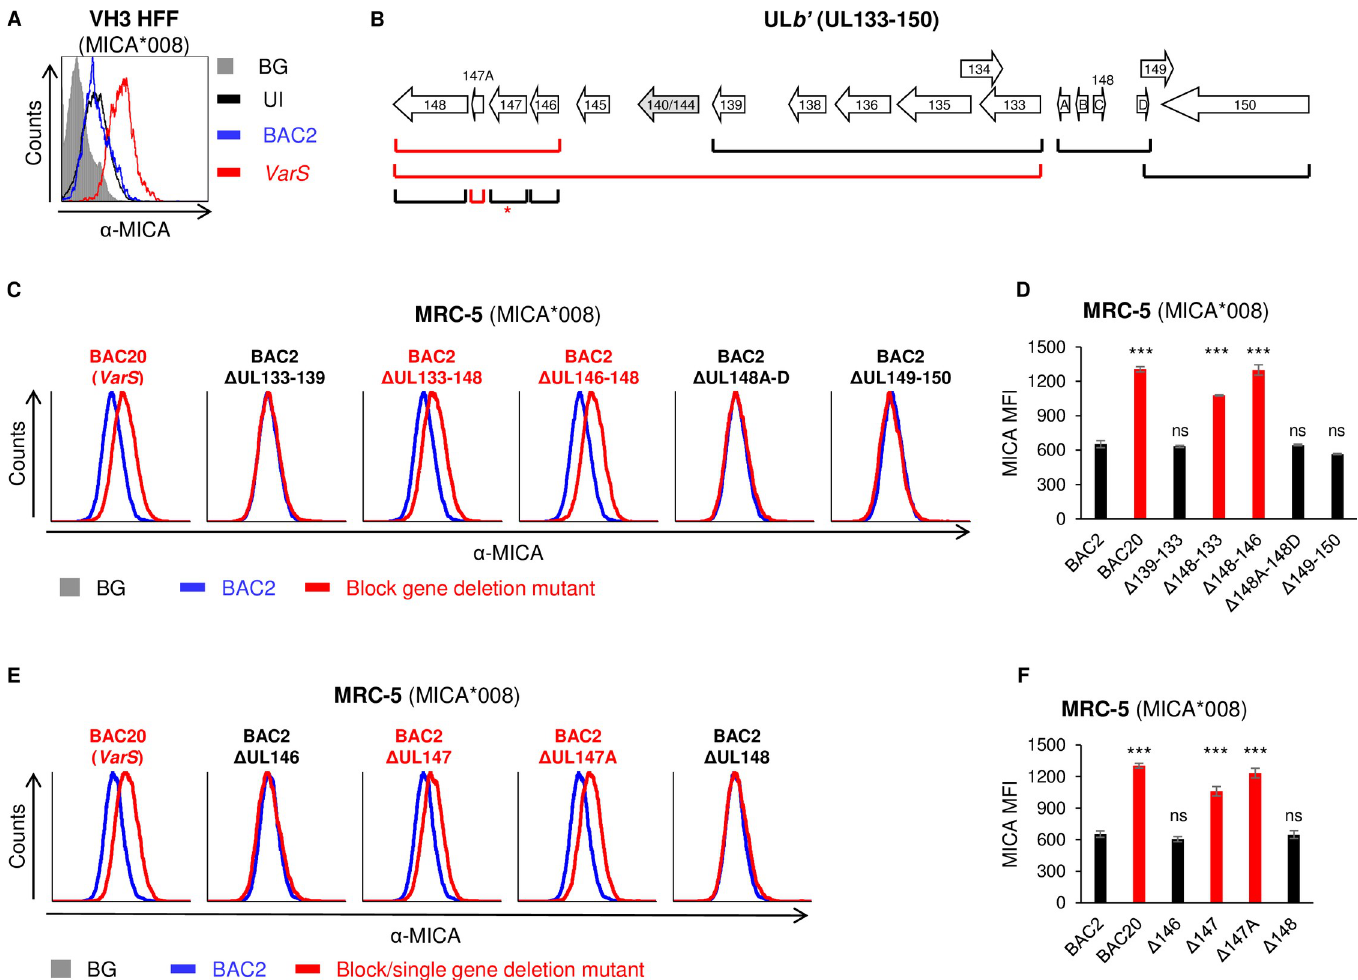
Fig 1. UL147A-deficient HCMV mutants are impaired in MICA � 008 downregulation. (A) VH3 HFFs (MICA � 008 homozygous) were either uninfected or infected with the indicated HCMV strains. Cells were harvested at 96 h post infection (hpi), and MICA surface expression was assayed by flow cytometry. Gray-filled histogram represents an isotype control staining of uninfected cells, all control stainings were similar to the one shown. (B) Diagram of the UL b’ genomic region (UL133–150). Brackets indicate block or single gene deletions generated on the BAC2 background. Red brackets indicate deletion mutants impaired in MICA � 008 downregulation. Red asterisk next to the BAC2 Δ UL147 mutant indicates impaired MICA � 008 downregulation caused by disruption of UL147A, as shown in S1 Fig. (C-F) MRC-5 HLFs (MICA � 008 homozygous) were either uninfected or infected with the indicated HCMV strains. Cells were harvested at 72 h post infection (hpi), and MICA surface expression was assayed by flow cytometry. Shown are block deletion mutants (C) and their quantification (D) or single gene deletion mutants (E) and their quantification (F). Data show mean ± SEM for at least three independent repeats per mutant. A one-way ANOVA comparing all HCMV-infected cells was performed with a significant effect at the p < 0.05 level for all conditions [F (10,73) = 47.37, p = 6.7 � 10 − 28 ]. MICA median fluorescence intensity (MFI) for BAC2 was compared to each mutant’s MFI using a post-hoc Dunnett’s test. Red font and bars highlight deletion mutants whose phenotype matches that of UL b’ -deficient virus. ��� p < 0.001, ns not significant.Full experimental data and statistics can be found in S1